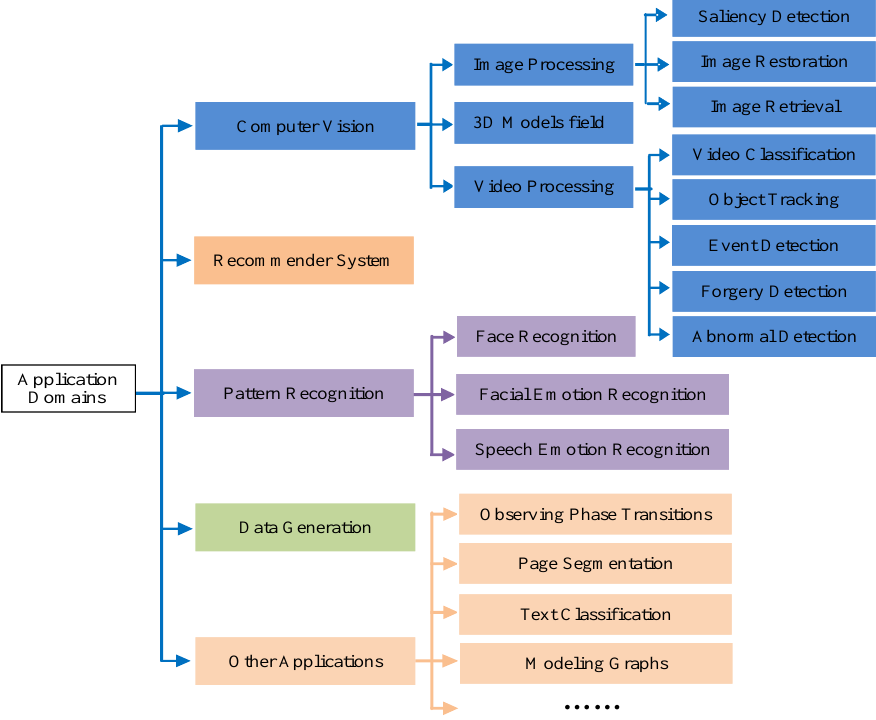
Figure 6. The taxonomy of the application domains of